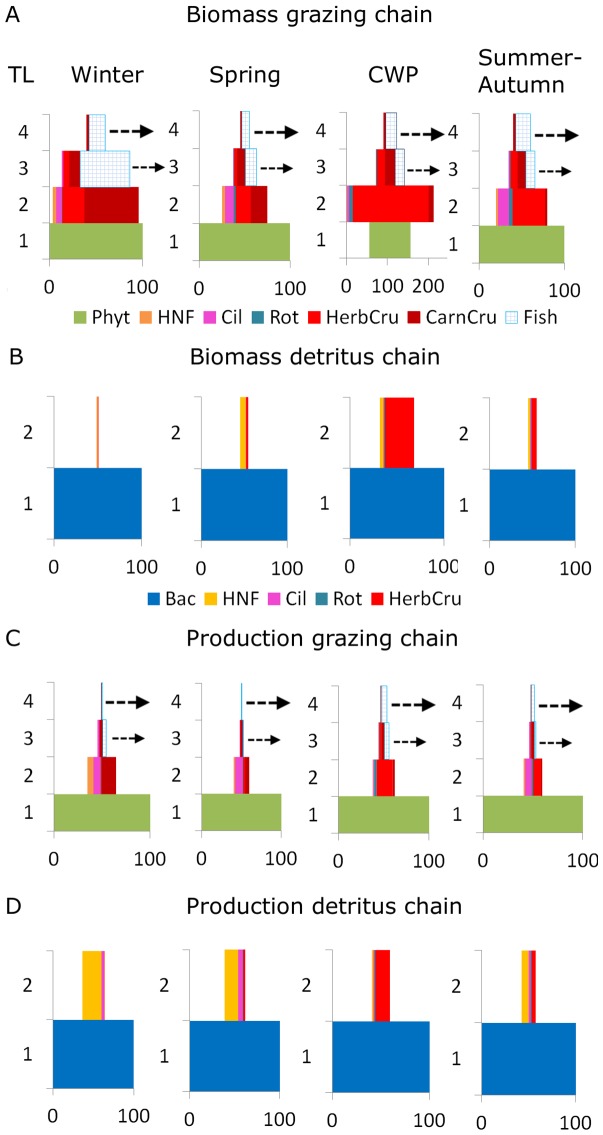
Seasonal changes in trophic structure.(A) The biomass pyramids of the grazing chain and (B) the detritus chain on ascending trophic levels for the 8 major functional groups in units of carbon. Summer and autumn data were pooled to summarize similar distributions. (C) The production pyramids of the grazing chain and d) the detritus chain. Autotrophic biomass and primary production (PP) in (A, C) and bacterial biomass and production (BP) in (B, D) was set to 100% in each phase. Without this standardization, the ratio between PP and BP is approximately 9:1 (cf. Fig. 1D). Seasons and groups in (B–D) same as in (A–B). The detritus chain only shows two trophic levels because consumers partly feeding on bacterivores were assigned to the grazing chain. Arrows indicate that fish biomass and production were underestimated because fish biomass is reduced by commercial fisheries in LC (cf. Methods).